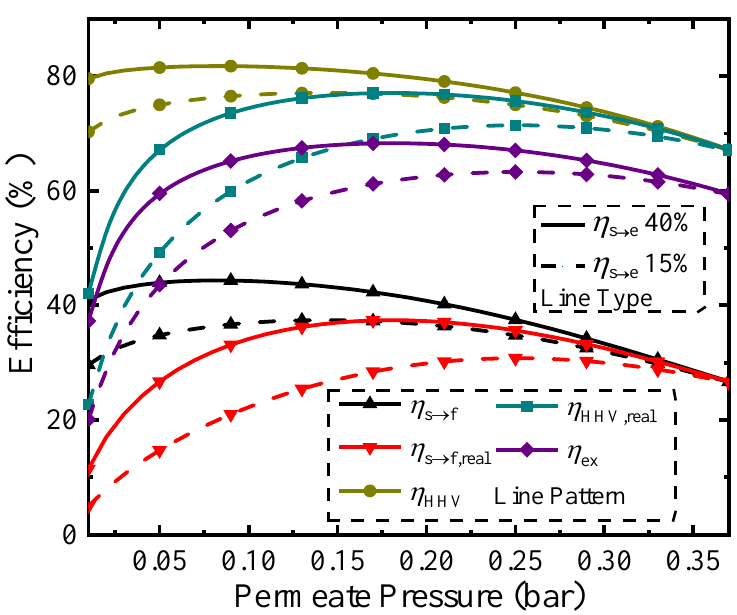
Figure 4. Thermodynamic efficiency versus permeate pressure at a reaction temperature of 150 °C.